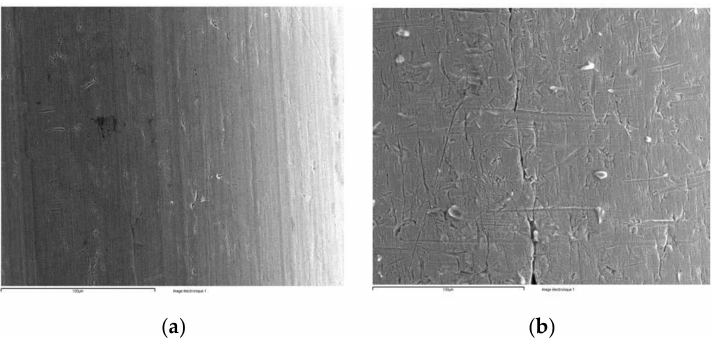
Figure 17. Images of hypotube #4: ( a ) before the intergranular test (scale = 100 µ m) and ( b ) after the intergranular test (scale = 100 µ